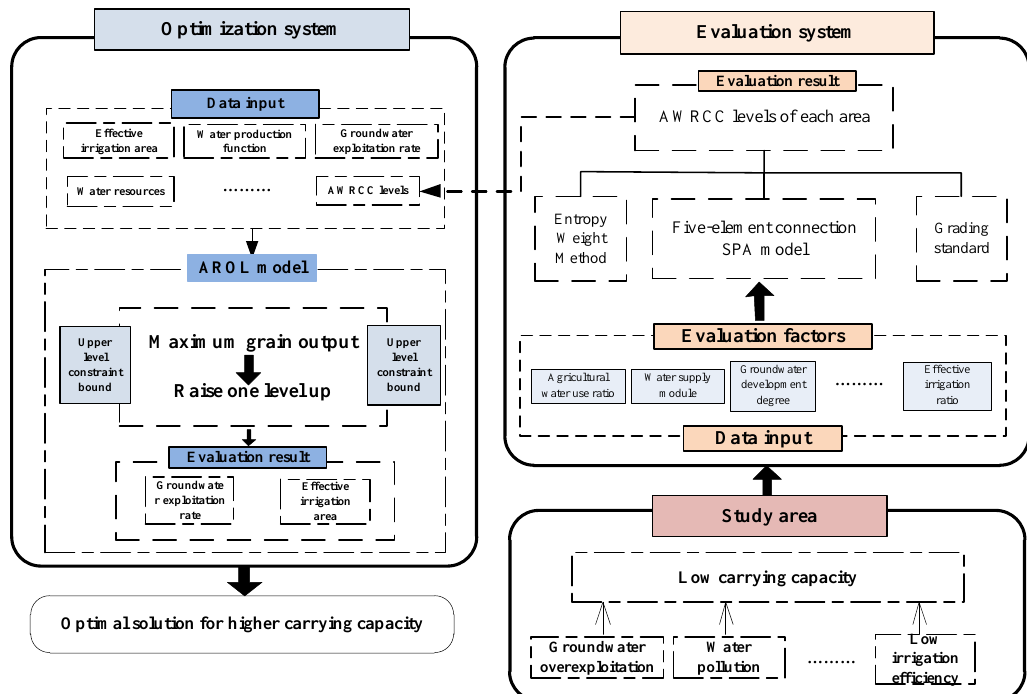
Figure 2. System Figure 2. System framework.